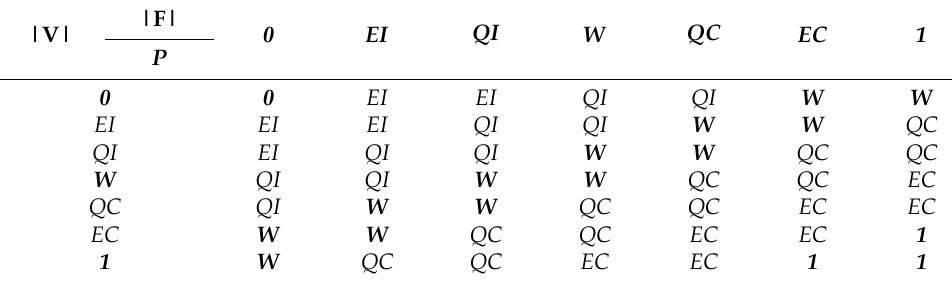
Table 4. Rule base for HA controller for | V